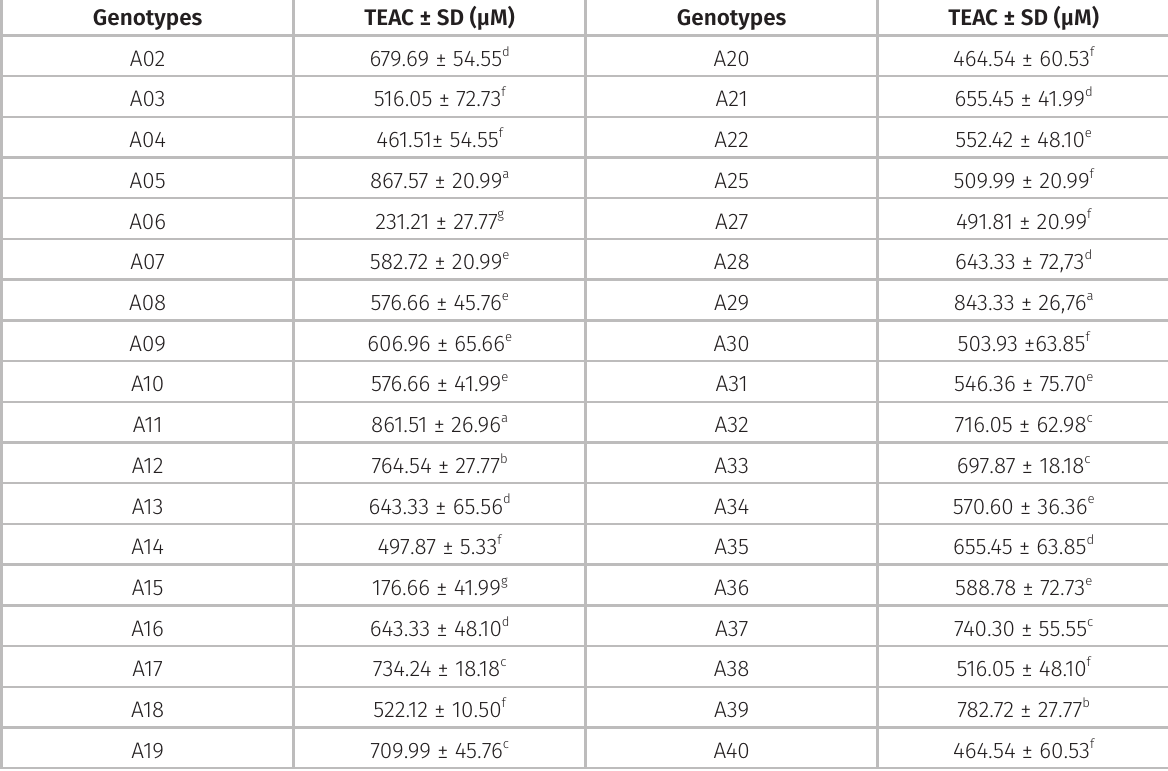
Table III. Antioxidant activity of essential oils extracted from leaves of different genotypes of E. uniflora by the DPPH